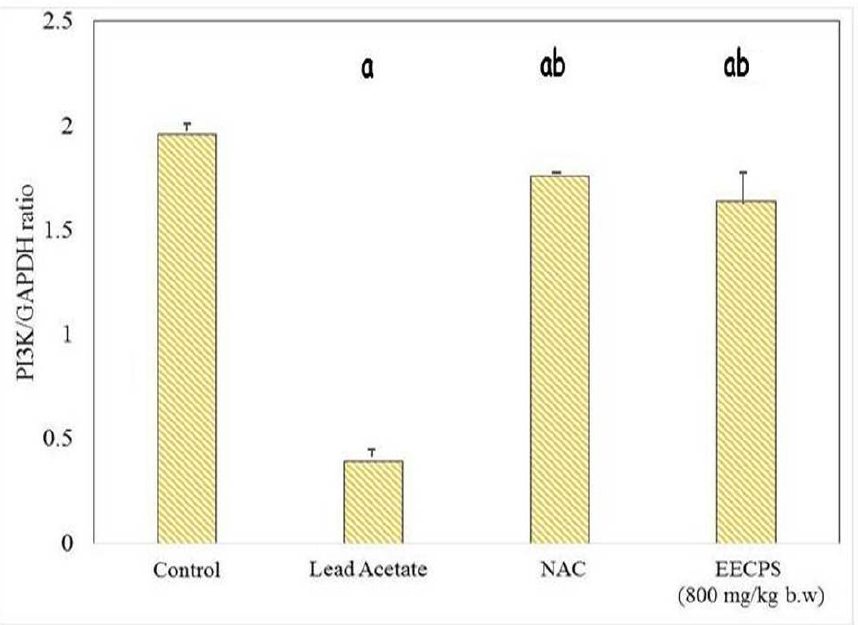
Figure 11. Graphical representation of PI3K mRNA expression in the kidney. a Significantly different from the control group. b Significantly different from the lead acetate group.